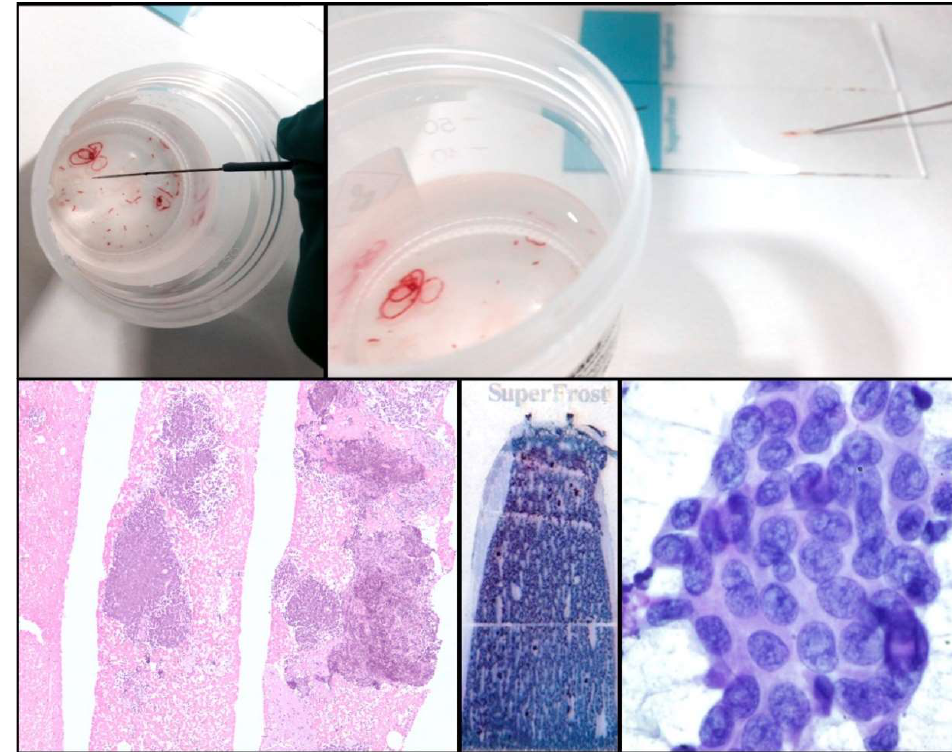
Figure 3. Wet Suction procedure.